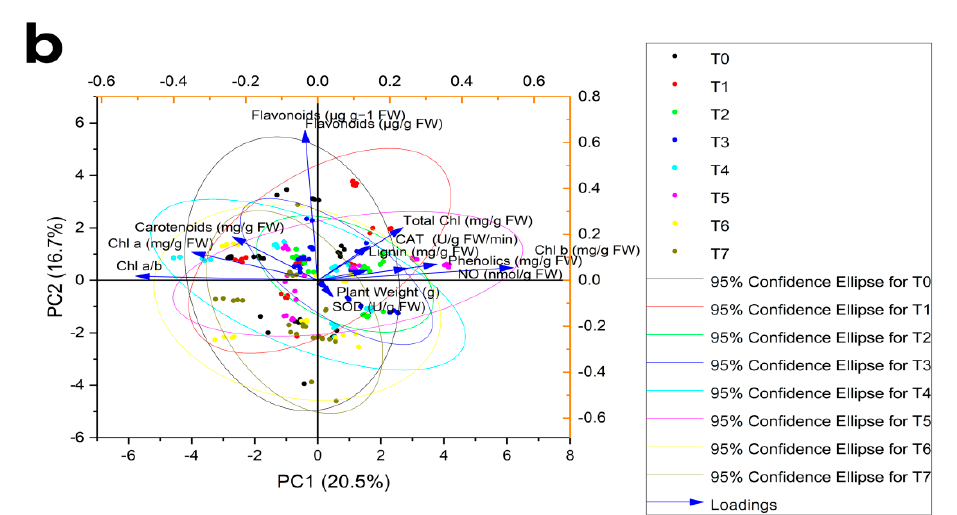
Figure 5. ( a ) Pearson correlation for different phytochemical analysesof Silybum marianum in hydro- ponics culture with different treatments where (T0 = control, T1 = methyl jasmonate, T2 = silver nanoparticles, T3 = fungal elicitors, T4 = methyl jasmonate + fungal elicitors, T5 = methyl jasmonate + silver nanoparticles, T6 = fungal elicitors + silver nanoparticles, T7 = methyl jasmonate + silver nanoparticles + fungal elicitors). ( b ) Principal component analysis of the effect of various treatments application in hydroponics culture to enhance phytochemicals of Silybum marianum .